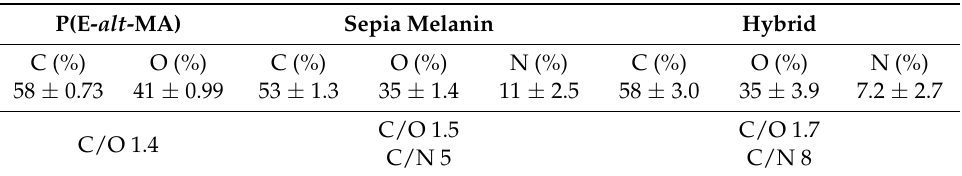
Table 1. Elemental percentages and ratios obtained by EDX.